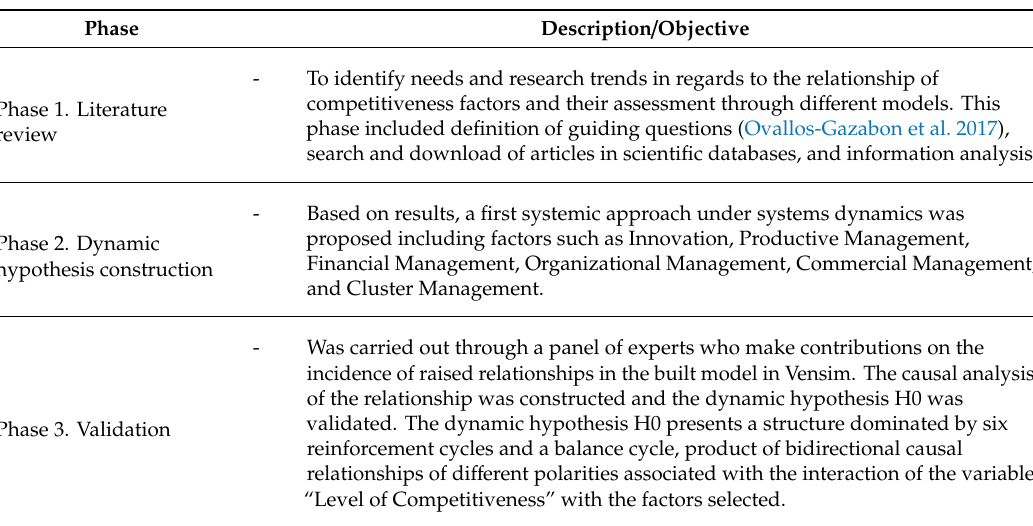
Table 1. Cluster competitiveness